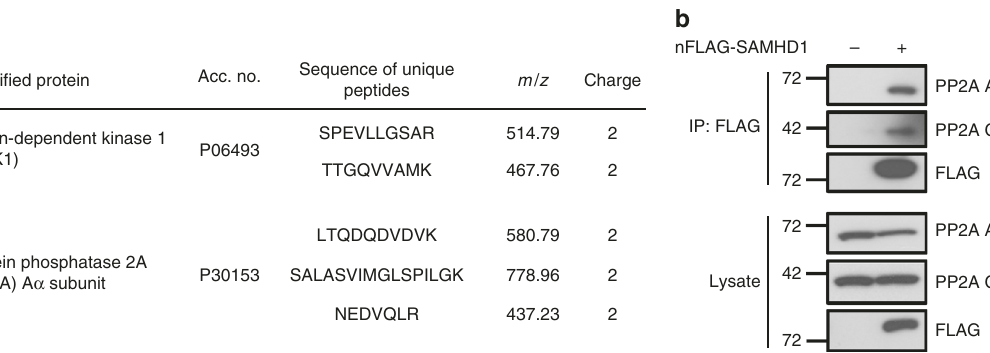
Fig. 2 SAMHD1 interacts with endogenous PP2A in cycling cells. a Identi fi cation of PP2A A α subunit and CDK1 as SAMHD1-interacting proteins using MS- based interactomics. Anti-GFP trapping of the same amount of lysates from GFP or GFP-SAMHD1 overexpressing cells was executed. The traps were subjected to on-bead trypsin digestion followed by nano-LC-MS/MS analysis for identi fi cation of interacting proteins. PP2A A α subunit and CDK1 were present on the GFP-SAMHD1 trap and not on the GFP trap, their identi fi cation being based on the presence of 3, respectively 2 unique peptides. b SAMHD1 interacts with endogenous PP2A A and C subunits. HEK293T cells were transfected with constructs expressing N-terminally FLAG-tagged SAMHD1 or empty vector as a negative control. 48 h post-transfection, cells were harvested, lysed and co-immunoprecipitations (CoIPs) performed using anti-FLAG- coated agarose beads. Proteins were analyzed by immunoblotting using antibodies speci fi c to the indicated proteins. Data shown are representative of